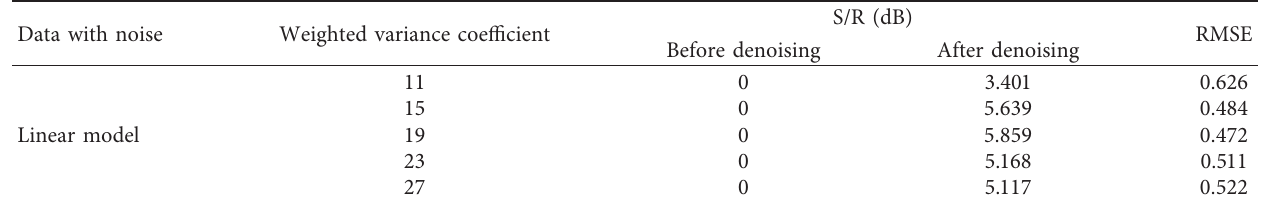
Figure 6: Comparison of denoising results. (a) Denoising result by SS. (b) The difference between noisy data and noise elimination by SS. (c) Denoising result using TF-SS. (d) The difference between noisy data and noise elimination by TF-SS. (e) The local similarity between (a) and (b). (f) The local similarity between (c) and (d). Table 2: S/R and RMSE after denoising under different filter